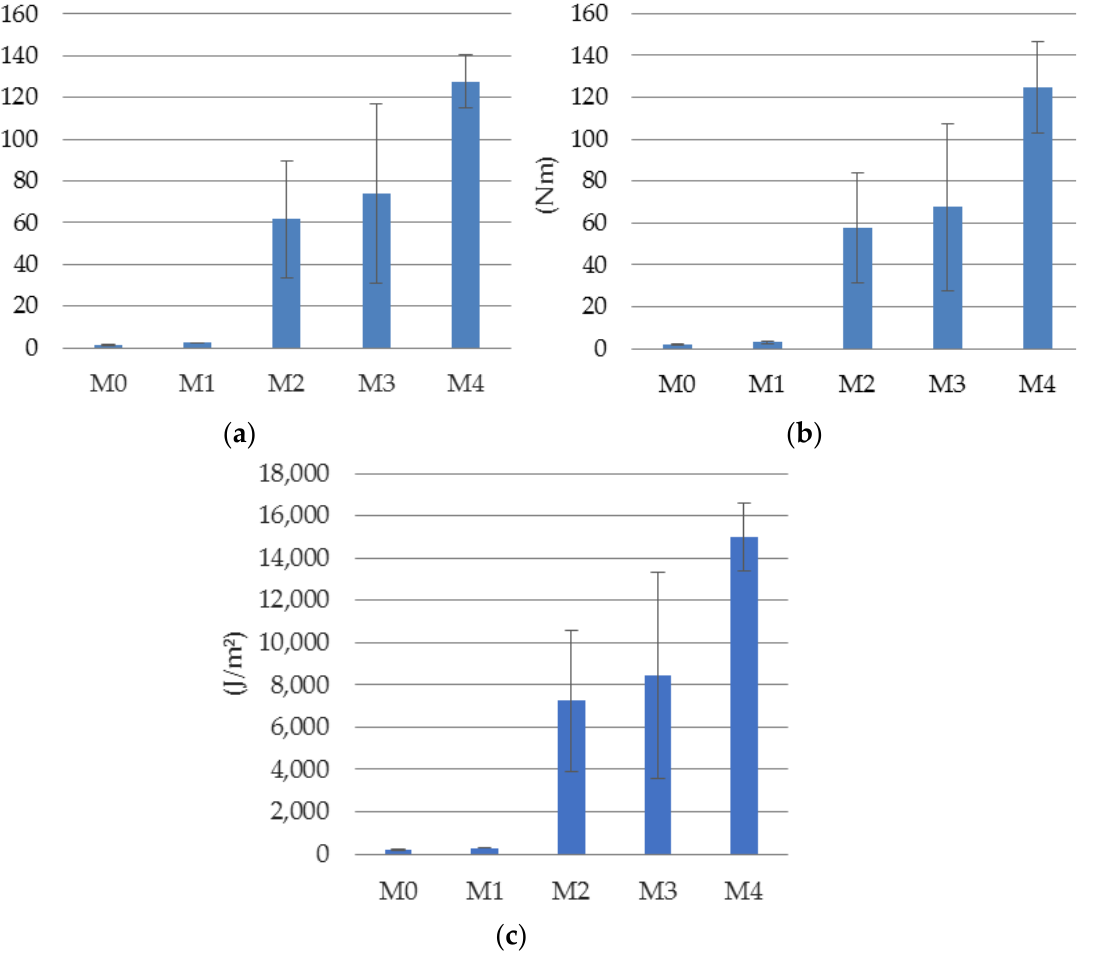
) and ( b ) F - CMOD ( W CMOD ), 0 0